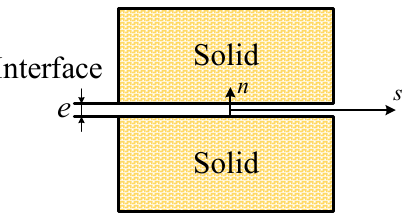
Figure 1. Interface element with relative nodal displacement.